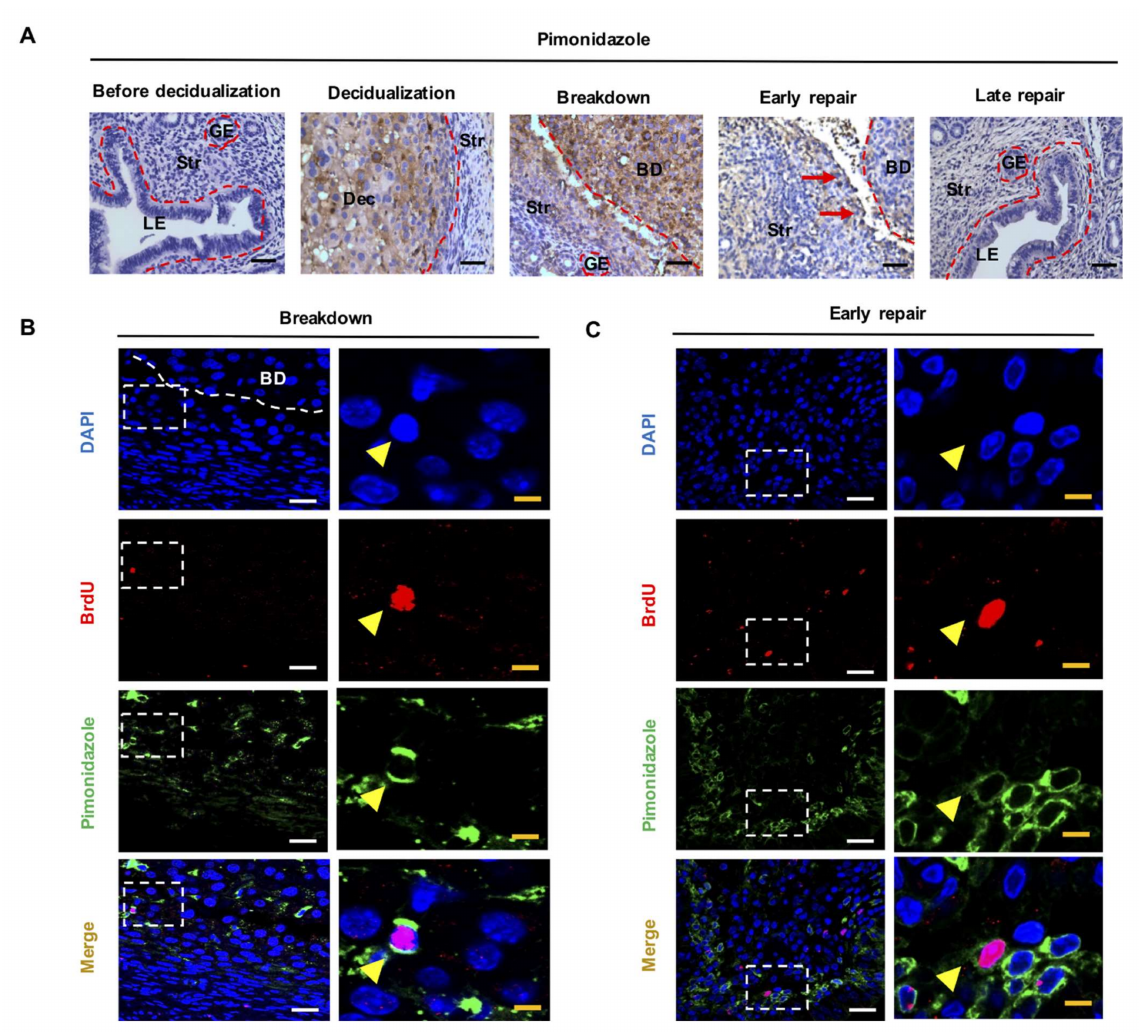
Figure 1. LRSC reside in a hypoxic microenvironment during endometrial breakdown and early repair. ( A ) Immunohistochemical images of pimonidazole staining (brown) at different time points of the mouse menstrual-like model, scale bar: 20 µ m. Red arrows indicate the unrepaired area. Repre- sentative immunofluorescence images show LRSC colocalizing with hypoxic marker pimonidazole (yellow arrow) at ( B ) breakdown and ( C ) early repair. Right panels are enlarged figures of white box in the left panels. Scale bars: left panels 20 µ m; right panels 5 µ m. n = 3–5 mice per group. Abbreviations: BD, breakdown; BrdU, bromodeoxyuridine; Dec, decidua; GE, glandular epithelium; LE, luminal epithelium; LRSC, label-retaining stromal cells; Myo, myometrium; Str,